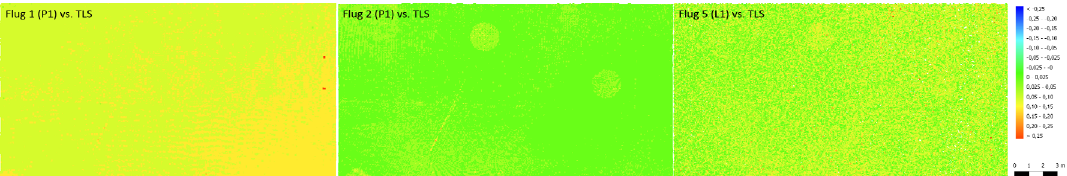
Figure 12 . Comparison of point clouds to TLS (reference) for UAV flights 1, 2 and 5 on test area 2.